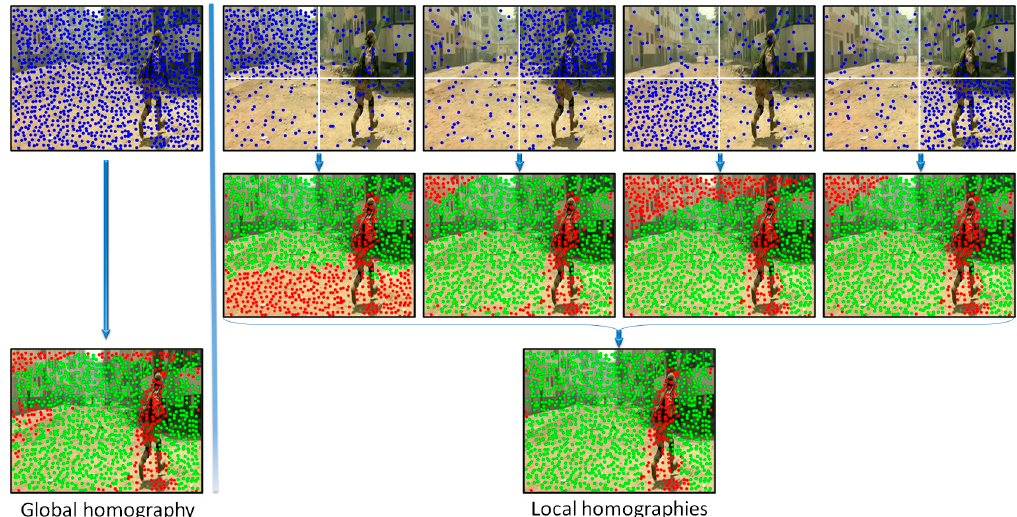
Figure 4. Background motion estimation using global versus local homographies (green points correspond to the background, while the red points are labeled as belonging to foreground objects in apparent motion).